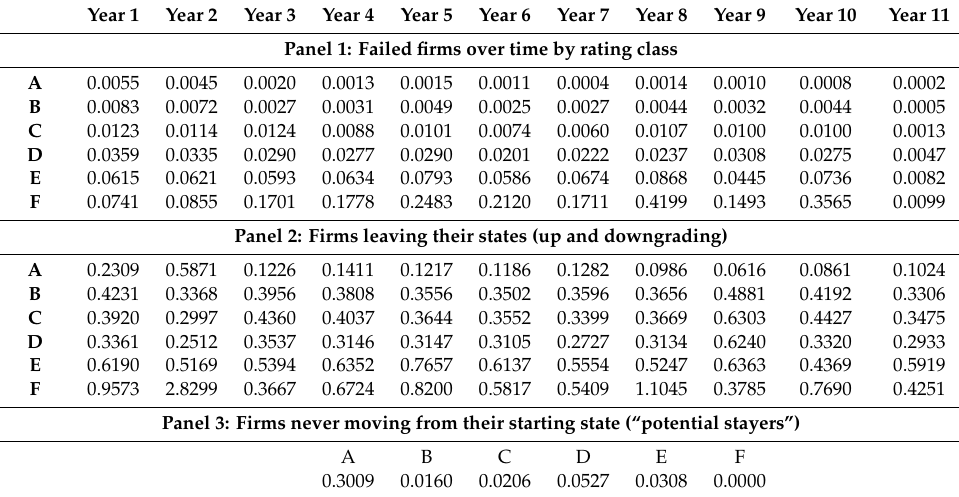
Table 2. Structure of the firms’ states evolution (relative values). Panel 1 shows the pattern of failed firms over time. Panel 2 contains the incidence of companies moving from one notch to another. Panel 3 shows the incidence of stayers, that is companies whose rating has never changed over the 11 years.